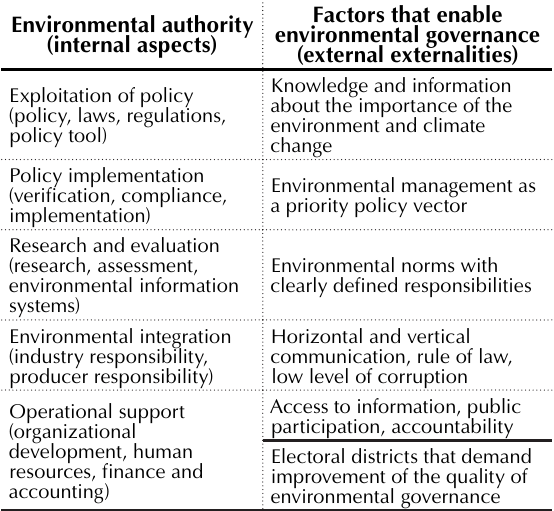
Table 1. Internal and external